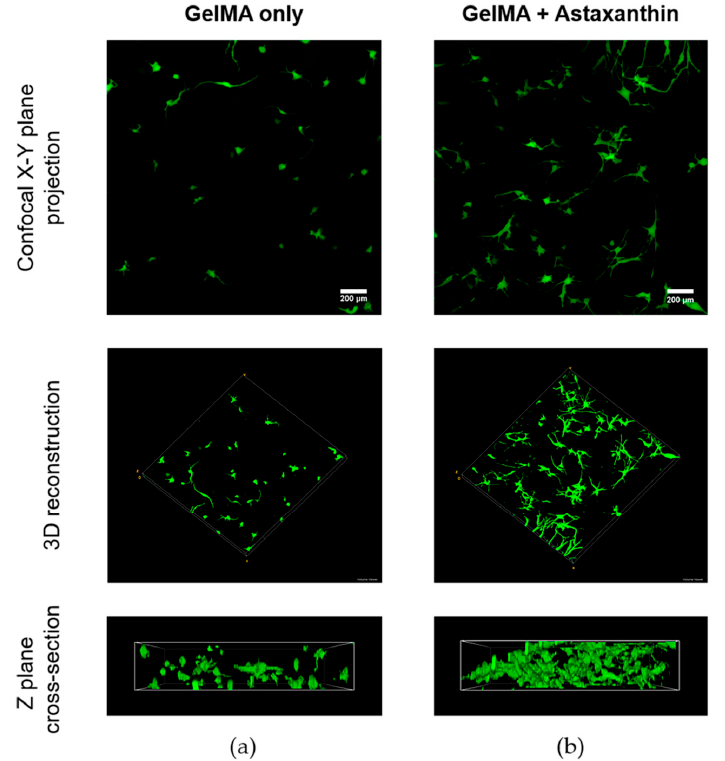
Figure 8. Confocal images of adipose-derived mesenchymal stem cells (ADMSCs) in GelMA ( a ) with and ( b ) without astaxanthin (0.5 ng/ml) using Live/dead staining after 8 days. (scale bar = 200 μ